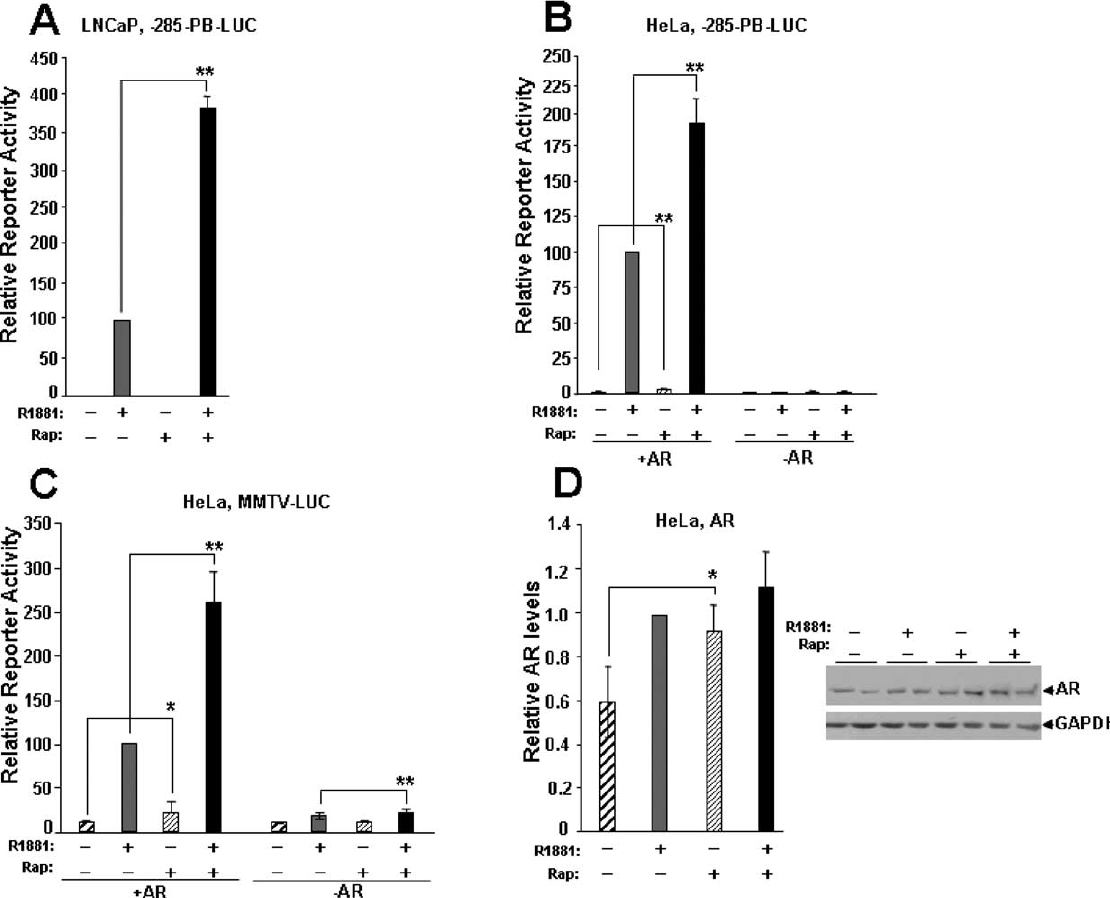
Fig. 3. mTOR inhibition increases the transactivation potential of AR. (A) LNCaP cells were cultured and transfected with -285-PB-LUC as described in Section 2. After transfection, cells were either left untreated, treated with rapamycin (100 nM), the synthetic androgen R1881 (10 − 8 M), or both, for 48 h as indicated. AR transcriptional activity was normalized to total amount of protein. Activity in the presence of R1881 was set to 100. (B) -285-PB-LUC was cotransfected into HeLa cells, either with an empty expression vector (pSG5) or an expression vector encoding AR (pSG5-AR). After transfection, cells were either left untreated, treated with rapamycin (100 nM), the synthetic androgen R1881 (10 − 8 M), or both, for 48 h as indicated. Cells were then harvested, luciferase activity was determined and normalized to total amount of protein. Activity in the presence of R1881 was set to 100. (C) Transfection into HeLa cells was performed as in B, but MMTV-LUC was used as the reporter. (D) Western analysis was performed with AR antibody on whole-cell extracts from HeLa cells transfected with 2 µg pSG5-AR and treated as in (B) and (C). Fold differences of AR levels were normalized to GAPDH levels, the values presented are relative to the AR level in cells treated with R1881 (set to 1). A representative Western blot, as well as quantification from two independent experiments done in triplicate, is shown. The differences between the groups were evaluated using one-tailed, paired Student’s t- test compared to non-treated samples, with P < 0 . 05 being considered as significant. Significance is indicated by asterisks, P < 0 . 05 and double asterisk, P < 0 . 01.